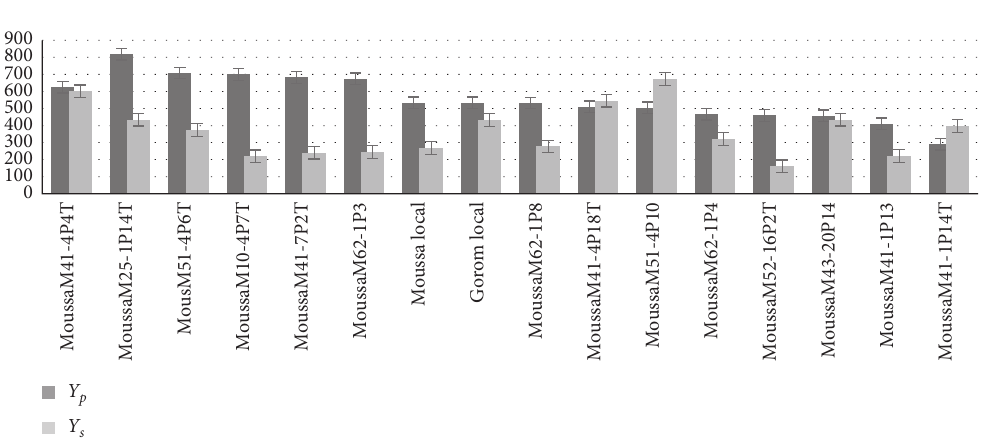
p : yield in nonstressed conditions (gram);